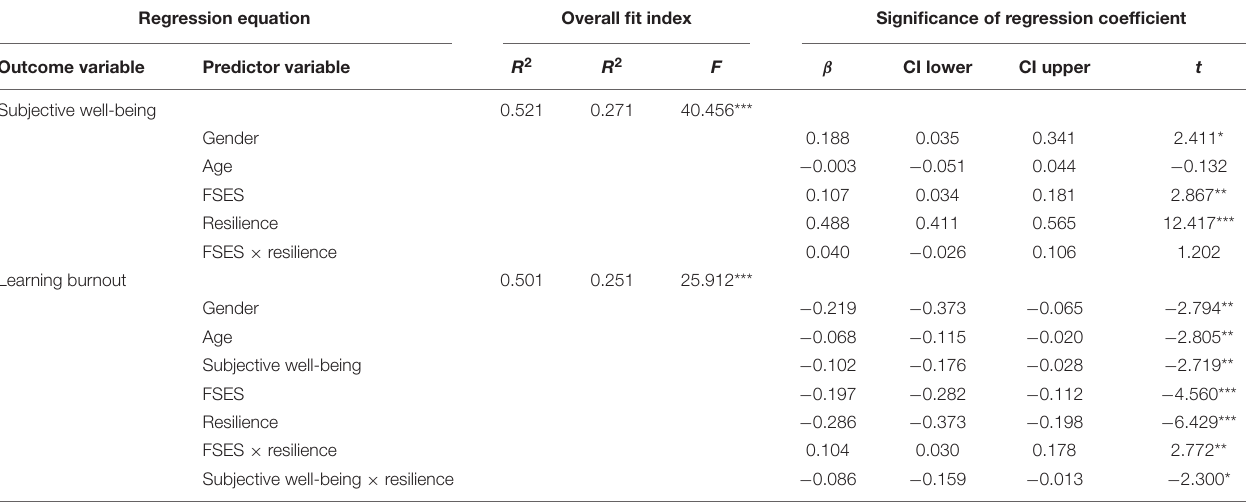
TABLE 4 | Moderated mediating model test.